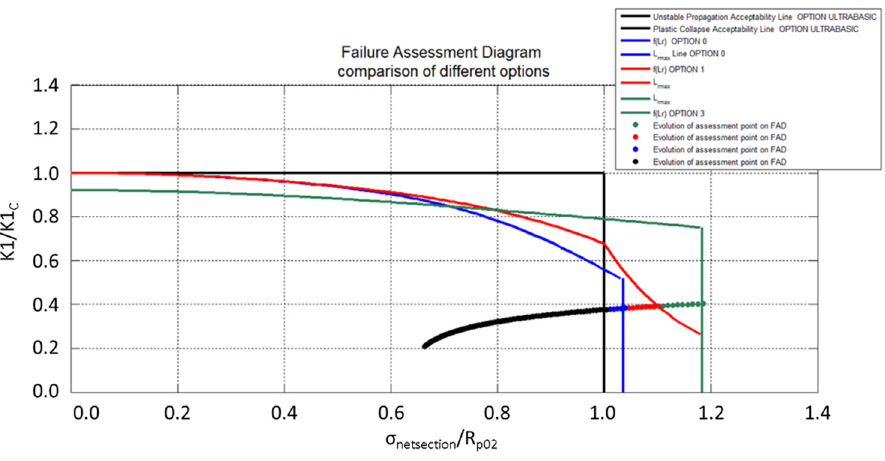
Figure 13. Example of a failure assessment diagram (FAD).